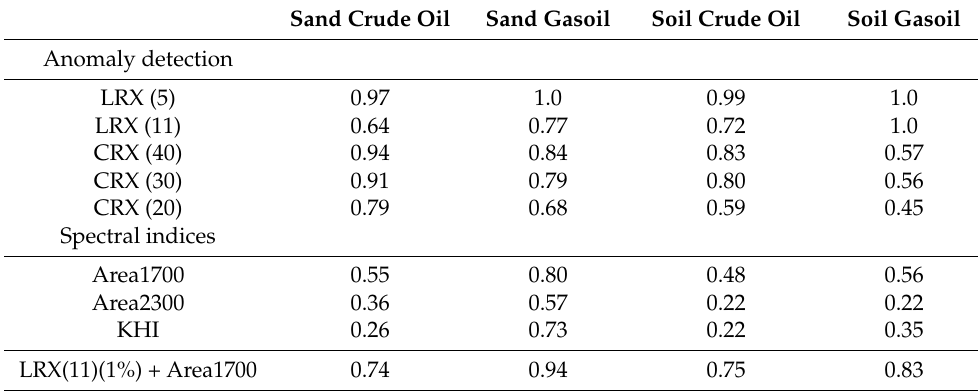
Table 1. LogAUC obtained with the different detection methods, anomaly detection LRX, CRX, and hydrocarbon indices calculations: Area1700, Area2300, and Kühn index (KHI). The last line corresponds to Area1700 applied to the most atypical 1% of pixels. The size of W g for LRX and the maximum number of classes for CRX are given in